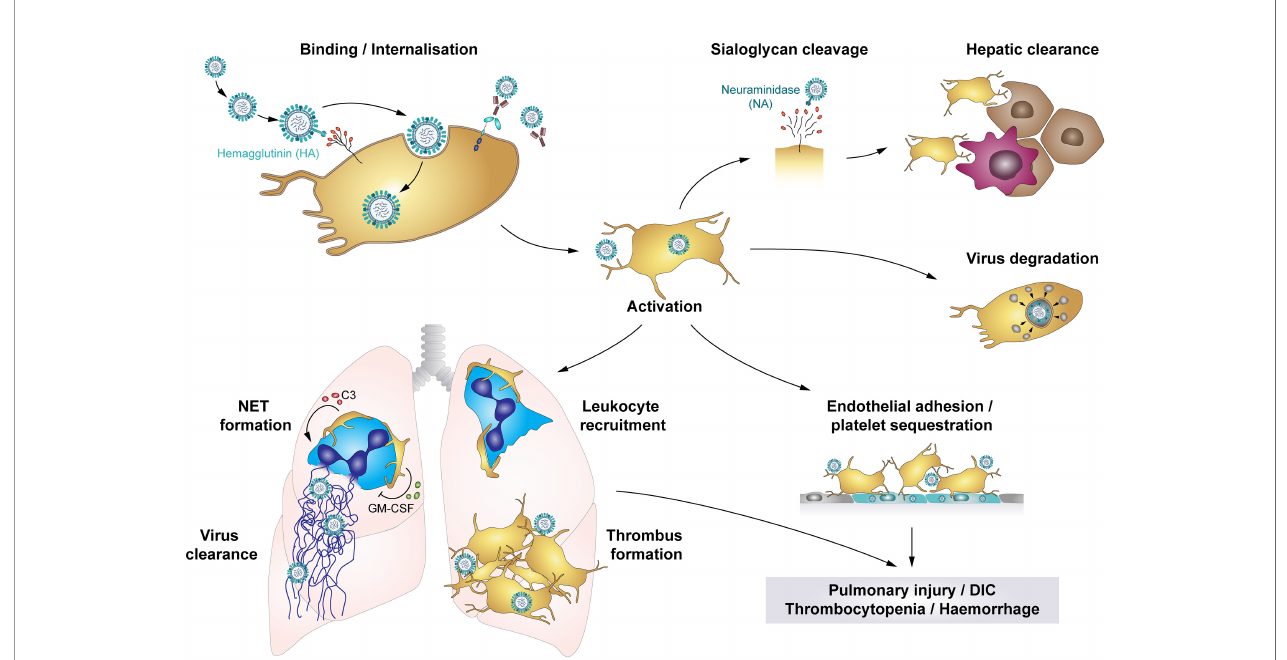
FIGURE 5 | The role of platelets in in fl uenza infections: Platelets bind and internalise in fl uenza virus via the interaction of virus hemagglutinin (HA) proteins and sialic acid (SA)-terminated glycans on the platelet surface, though platelets also bind in fl uenza-containing immune complexes. These interactions result in platelet activation and platelet-mediated immune responses that contribute to in fl uenza-associated pathologies. Cleavage of SA residues by viral neuraminidase (NA) induces platelet clearance by liver hepatocytes and Kupffer cells. However, rapid internalisation of viral particles leads to digestion of in fl uenza virus when vesicles with enclosed virions fuse with platelet granules that contain antimicrobial peptides. Systemically, in fl uenza-infected endothelial cells express pro-thrombotic factors like fi bronectin or integrin a 5 b 1 , which increases platelet adhesion to the endothelium and thus fosters platelet sequestration. Locally, platelets in fi ltrate the lung tissue, where thrombus formation may constrict and/or occlude blood vessels or small airways. Furthermore, platelet-leukocyte aggregate formation induces leukocyte recruitment and triggers the formation of NETs to entrap viral particles, regulated by C3 and GM-CSF. However, NETs cause further tissue damage and enhance thrombus formation. Together, these platelet-mediated responses in in fl uenza trigger pulmonary injuries, disseminated intravascular coagulation (DIC), thrombocytopenia and haemorrhages in severe in fl uenza infections. C3, Complement factor C3; DIC, disseminated intravascular coagulation; GM-CSF, Granulocyte-monocyte colony- stimulating factor; HA, hemagglutinin; NA, neuraminidase; NET, neutrophil extracellular